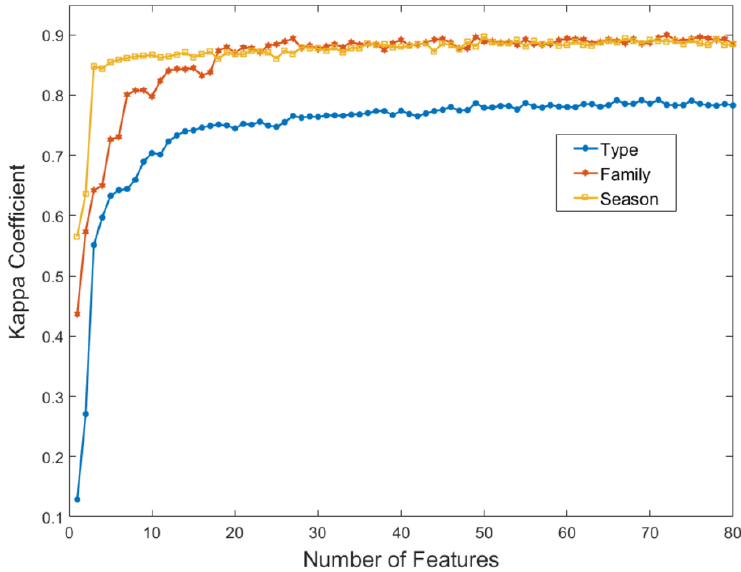
Figure 10. Kappa coefficient evolution for all levels of nomenclature using the RF classifier.